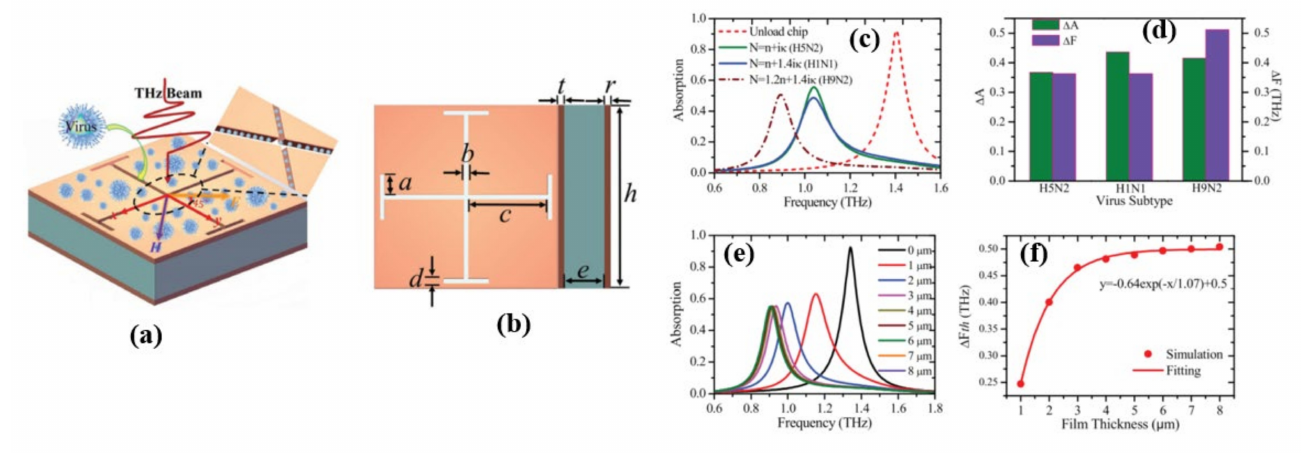
Figure 6. ( a ) 3D schematic diagram of the THz biosensing metamaterial absorber ( b ) geometrical parameters, ( c ) FDTD simulation results of absorption spectroscopy for three equivalent AI virus model samples: n + i κ (H5N2), n + 1.4i κ (H1N1), 1.2n + 1.4i κ (H9N2), ( d ) ∆ A and ∆ F of three different AI virus model samples: n + i κ (H5N2), n + 1.4i κ (H1N1), 1.2n + 1.4i κ (H9N2), ( e ) FDTD simulation results of absorption spectroscopy with analyte thickness for H9N2, ( f ) ∆ Fth versus different virus thickness of H9N2. Reprinted with permission from [52]. Copyright 2018